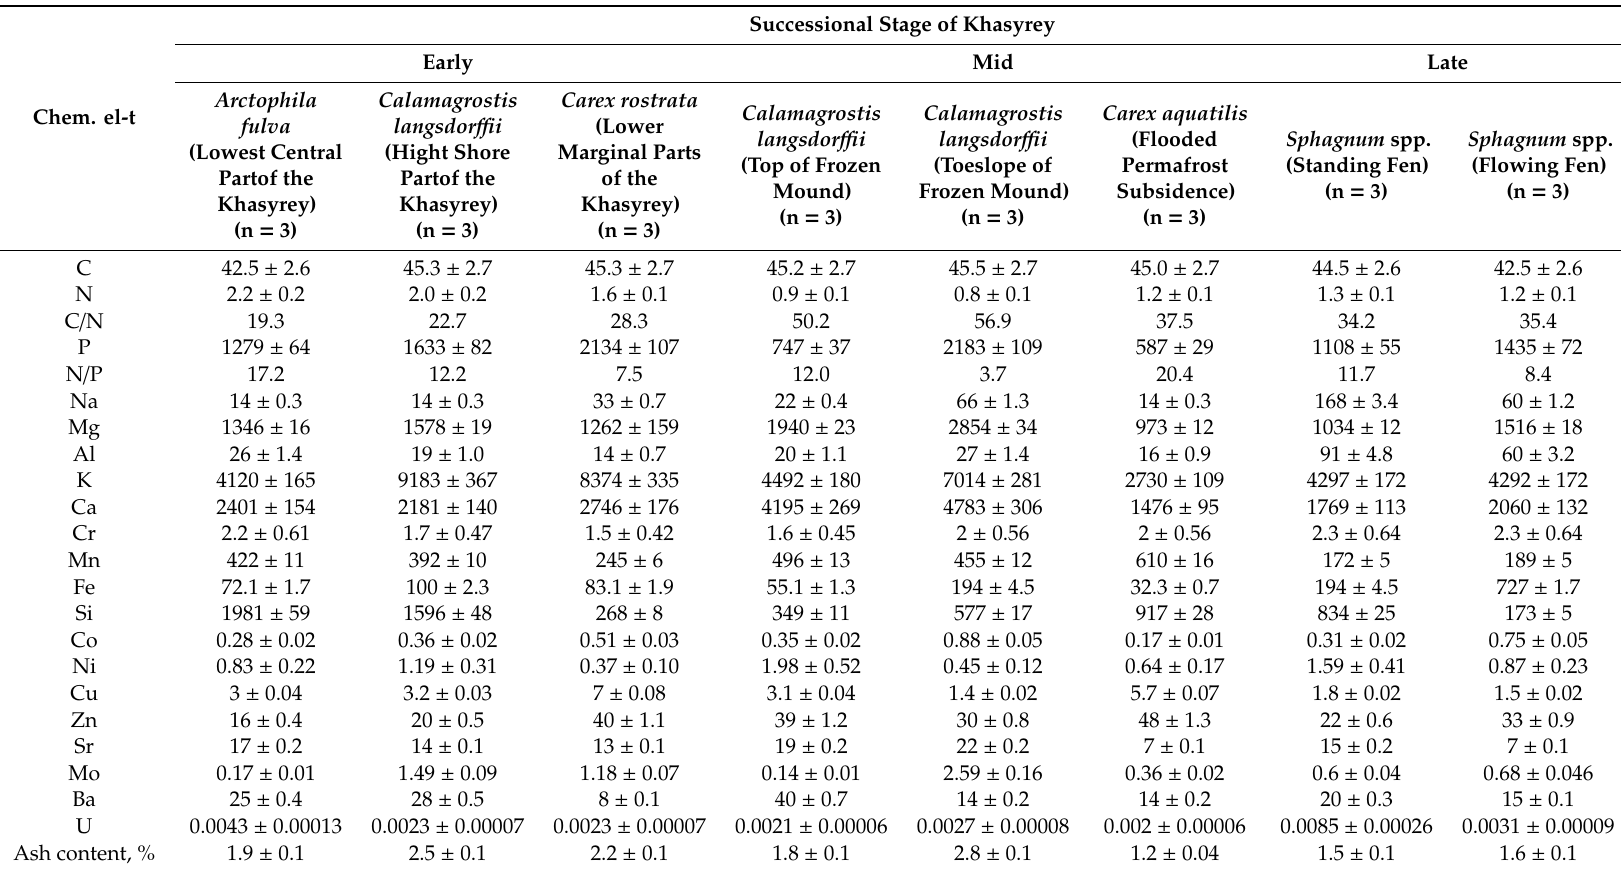
Table A5. Concentrations of carbon, nitrogen (%) and other chemical elements (mean ± S.D., ppm) in the main dominant plant species of di ff erent successional stages of